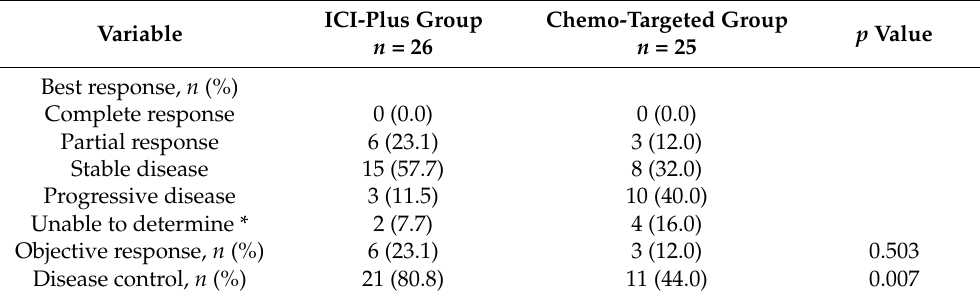
Figure 2. Best response and duration of each line of therapy since the application of anti-PD1/PD-L1 monotherapy in the ICI-plus group ( A ) and chemo-targeted group ( B ). For patients who lacked detailed information about treatment before the date of death or censoring, the graph bar was presented by blank. Abbreviations: ICI-plus: anti-PD1/PD-L1 plus other therapy; chemo-targeted: chemotherapy with or without targeted therapy; BSC: best supportive care; NA = not available; PD = progressive disease; PR = partial response; SD = stable disease. Table 2. Overall response between the ICI-plus group and chemo-targeted